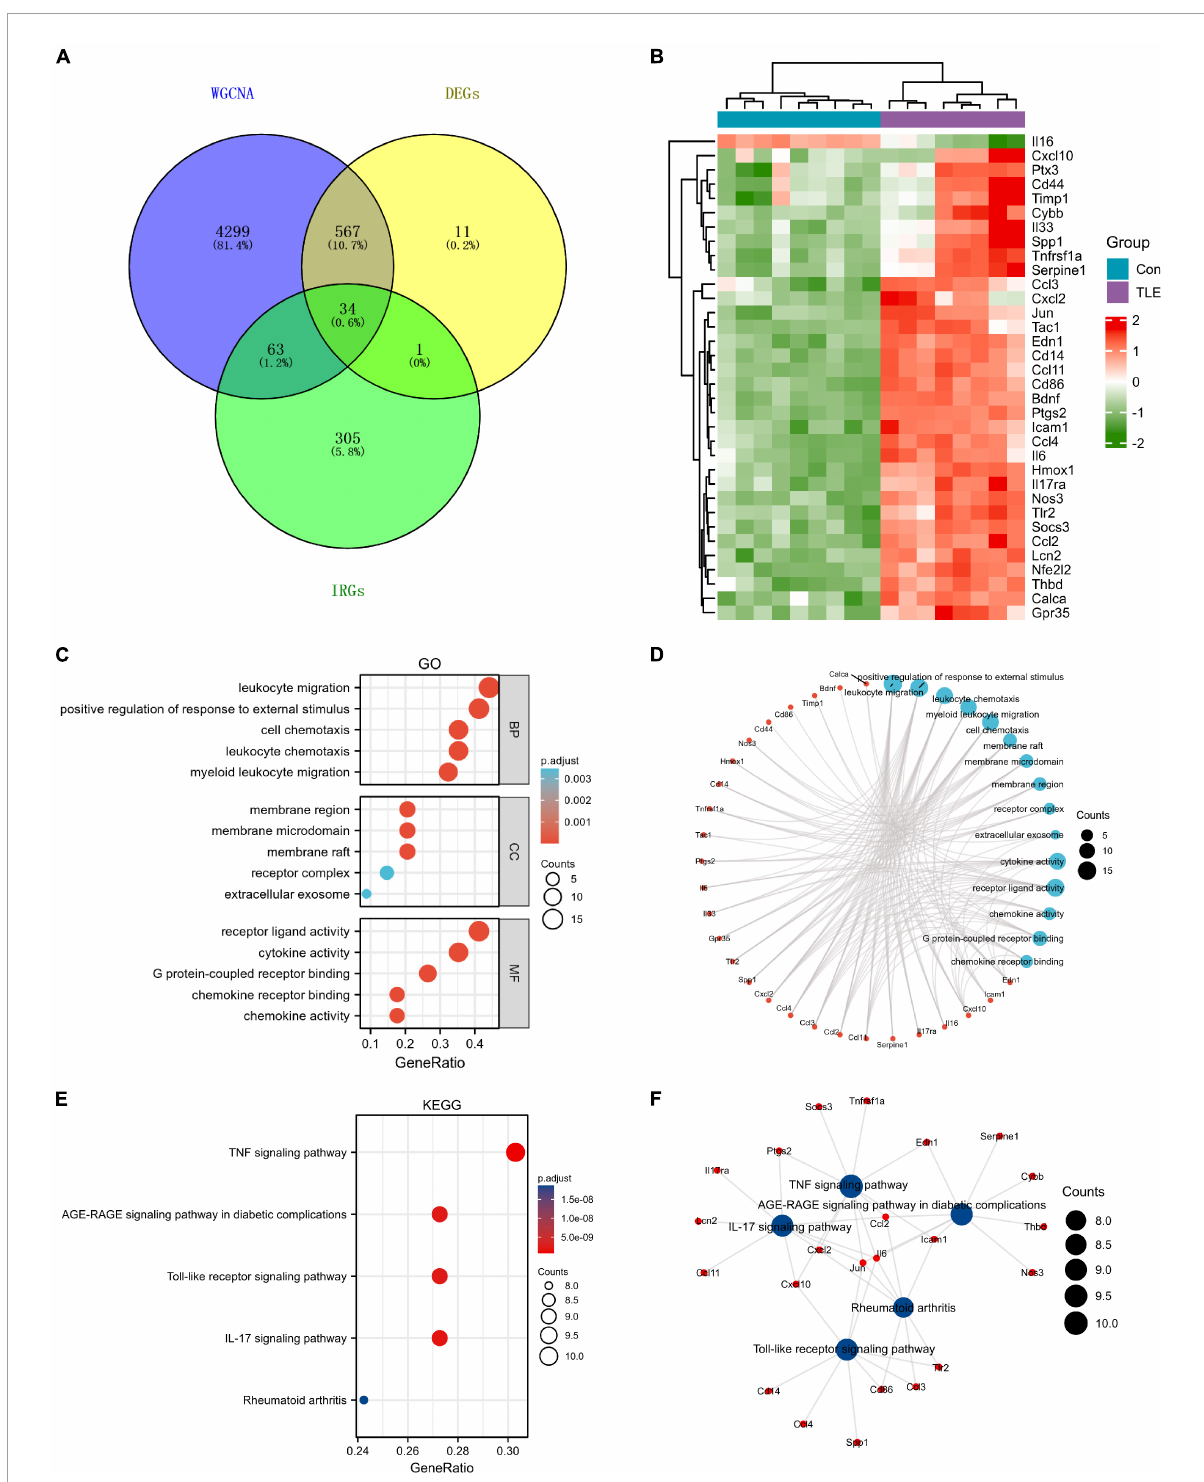
FIGURE2 Identification of differentially expressed IRGs (DEIRGs) in TLE. (A) Venn diagram of the DEIRGs in DEGs, WGCNA, and IRGs. A total of 34 DEIRGs were identified. (B) Heatmaps of the 34 DEIRGs in the GSE88992 dataset. Red indicates up-regulated and green indicates down-regulated. The results showed that most of DEIRGs were all up-regulated in TLE group. (C,D) Biological process (BP), cellular component (CC), and molecular function (MF) enrichment analyses of DEIRGs. (E,F) KEGG enrichment analysis of